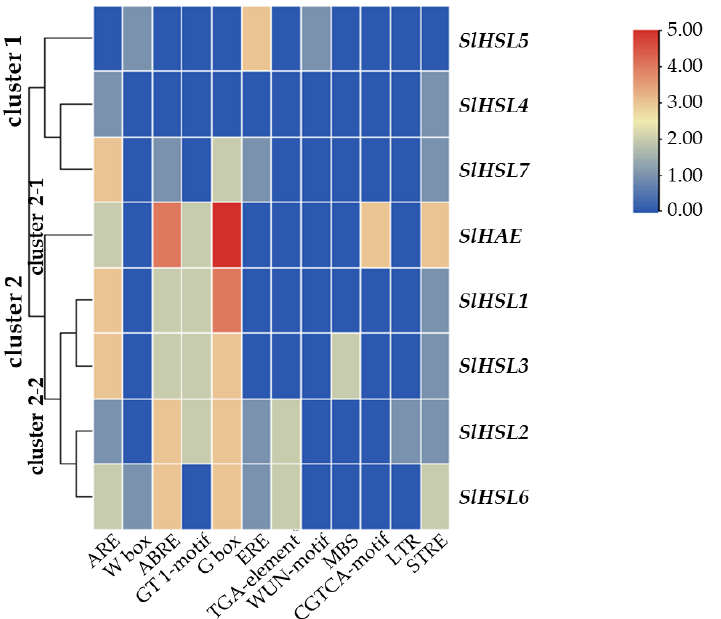
Figure 7. Cisregulatory elements in the promoter regions of SlHAE genes. ARE (anaerobic induction element), W-box (WRKY binding site), ABRE (cisacting element involved in the abscisic acid responsiveness), GT1-motif (light responsive element), G Box (cisacting regulatory element involved in light responsiveness), ERE (ethylene-responsive cisacting), TGA-element (auxin-responsive element), WUN-motif (wound-responsive element), MBS (MYB binding site involved in drought-inducibility), CGTCA-motif (cisacting regulatory element involved in the MeJA-responsiveness), LTR (low-temperature-responsive element), and STRE (stress response element) are identified in the promoters of eight SlHAE genes. Heatmap clustering for cisregulatory of SlHAE genes was generated with the Euclidean distance measurement and complete cluster method. Scale bars on the right indicate the relative enrichment for the identified cisregulatory elements.